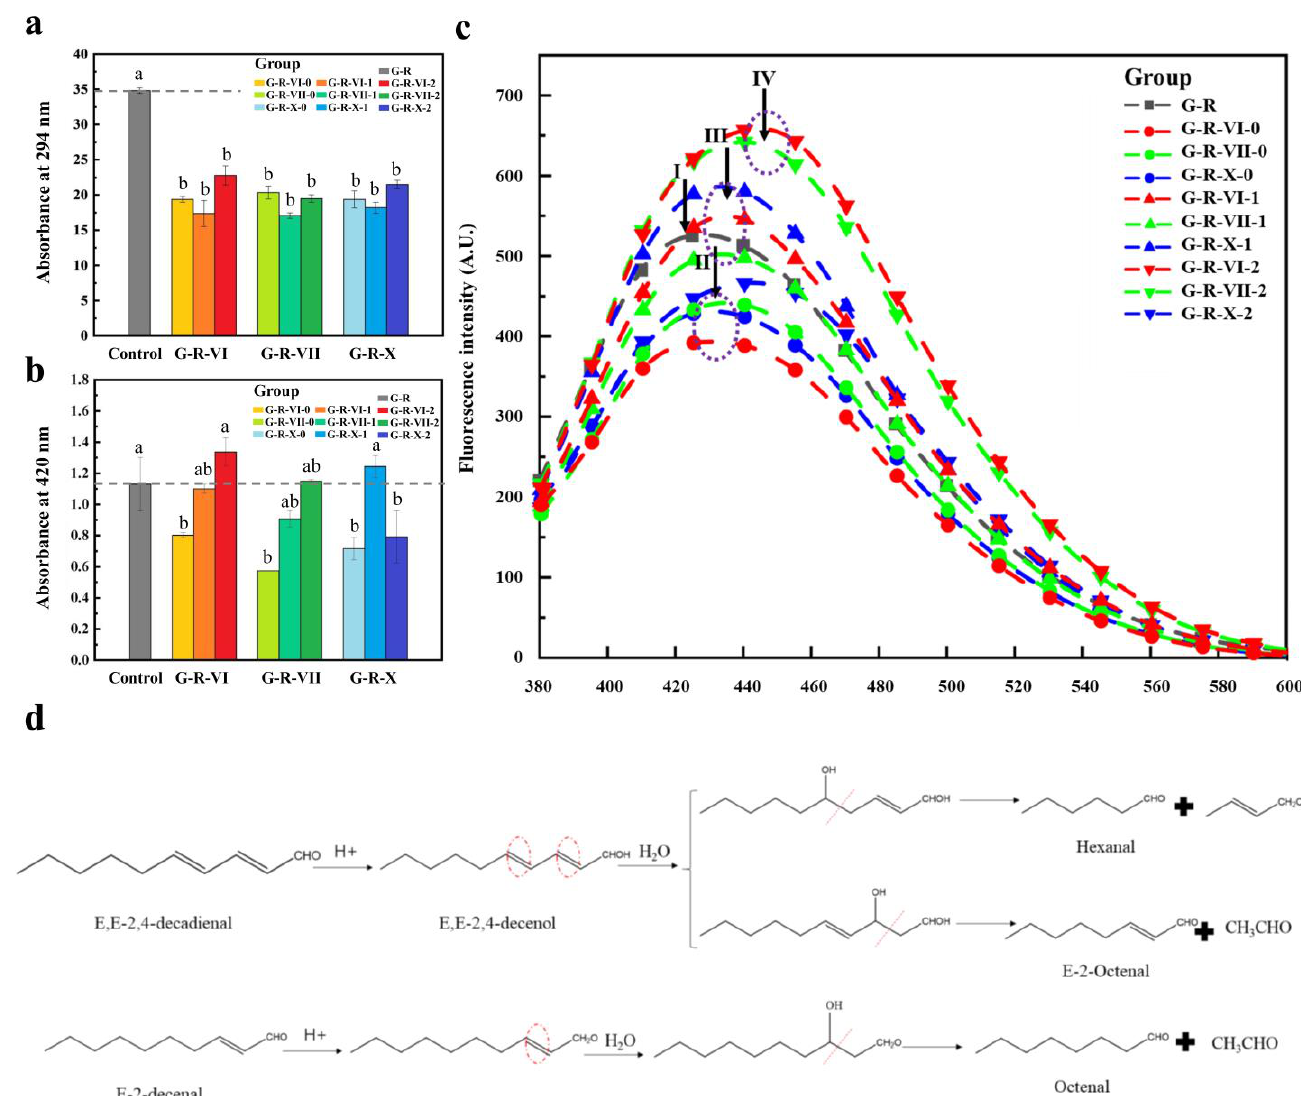
Figure 1. UV absorbance and fluorescence analysis of MRPs produced by MR systems with different aliphatic aldehydes: ( a ) absorbance at 294 nm, ( b ) absorbance at 420 nm, ( c ) fluorescence spectra; ( d ) reverse acetal reaction pathways of E , E -2,4-decadienal and E -2-decenal. Different lowercase letters denote significant differences ( p < The MR produces small molecules that generate fluorescence signals at 420 – 460 nm.